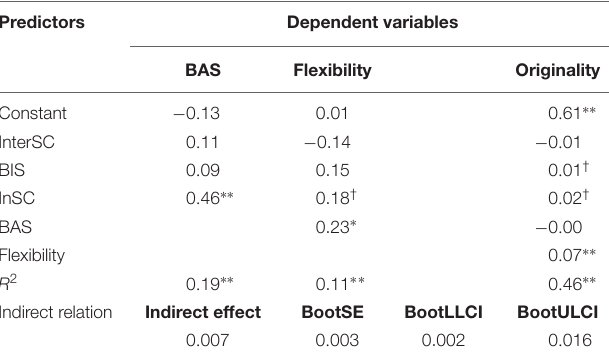
TABLE 5 | Study 2 regression results of the three-stage mediation model.